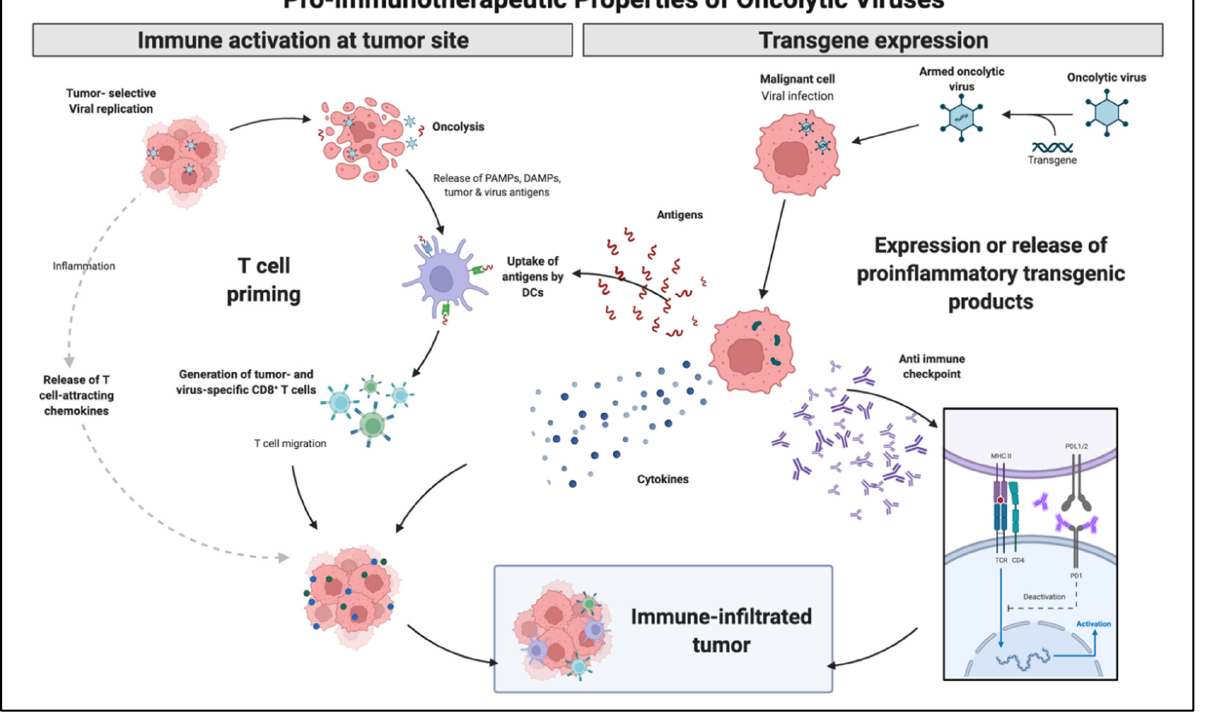
Figure 3. Immune enhancement mechanisms explored utilizing OVs strategies. OVs may generate increased immunologic response by direct cell lysis with antigen release and local inflammation as well as artificially generate pro inflammatory molecules by transgene expression. Adapted from “Properties of Oncolytic Viruses”, by BioRender.com (2022) (accessed on 28 March 2022). Retrieved from https://app.biorender.com/biorender-templates (accessed on 28 March